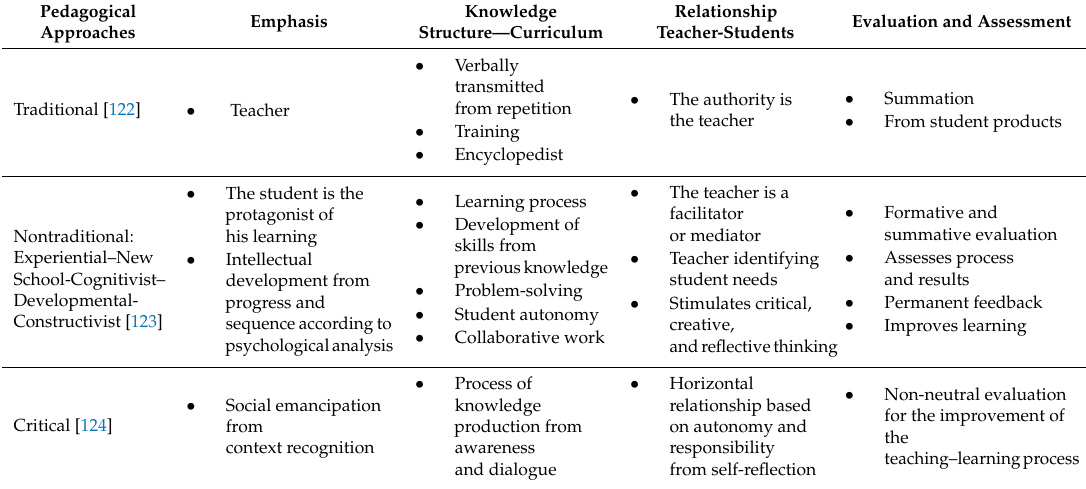
Table 5. Evaluation in contemporary pedagogy.